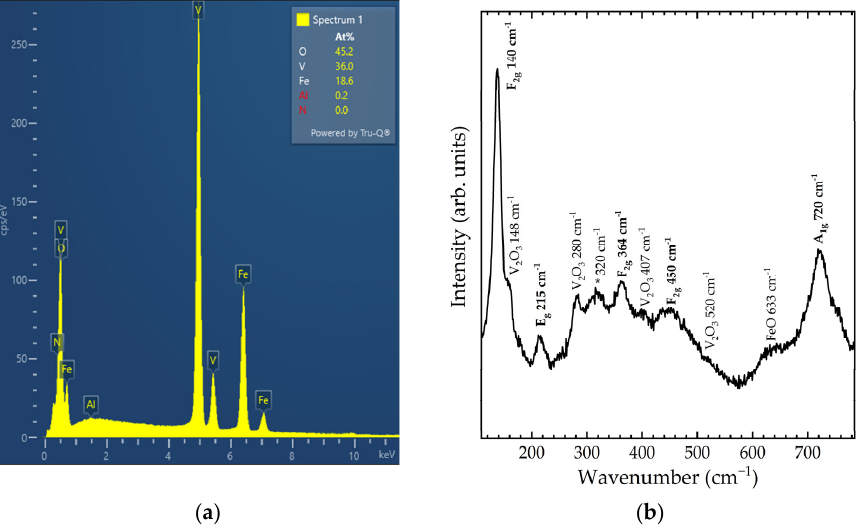
Figure 1. ( a ) EDXS analysis results and ( b ) Raman spectrum of the as-synthesised sample. Modes related to spinel FeV 2 O 4 are labelled in bold. Table 1. Experimental and calculated Raman mode frequencies (cm − 1 ) of spinel FeV 2 O 4 at ambient conditions compared with those of other isostructural vanadates.